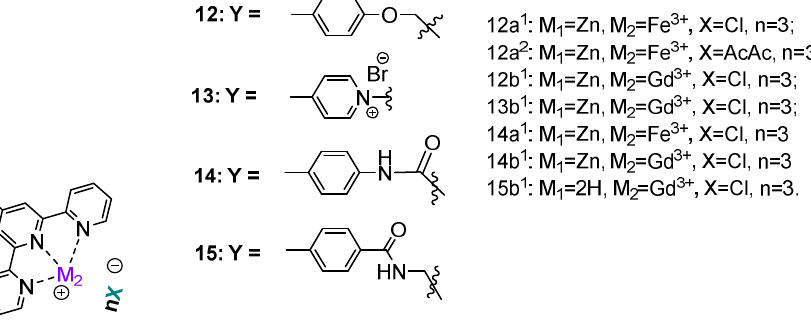
Figure 1. The structure of the obtained complexes. Table 2. Reaction condition and the yields of the metal complexes.